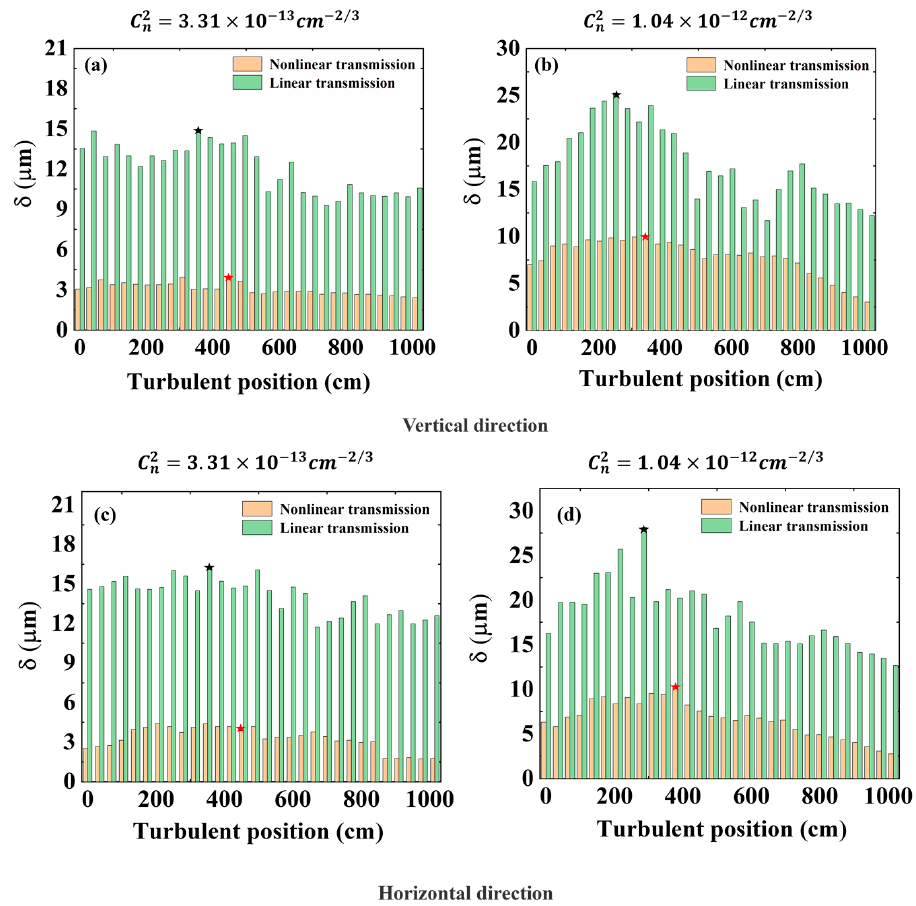
Figure 5. The standard deviation of beam wander in linear and nonlinear transmission at the same turbulent position. ( a , b ) Vertical direction; ( c , d ) horizontal direction; red pentacle, maximal value of δ in nonlinear transmission; black pentacle, maximal value of δ in nonlinear transmission.